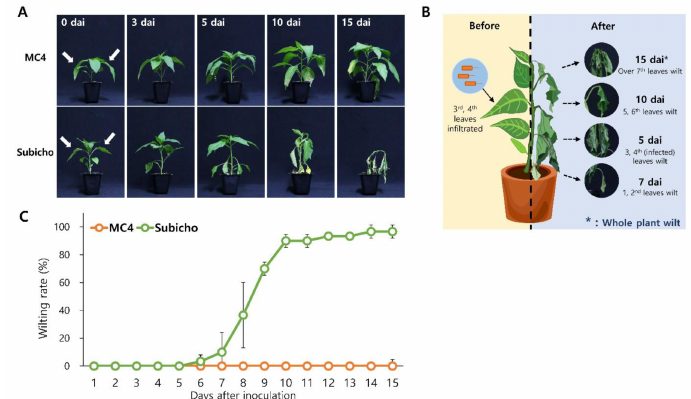
Figure 2. The difference in disease symptoms of leaf to whole plant spread bioassay (LWB) in pepper. Three weeks after transplanting, the eight-leaf stage seedlings were inoculated with R. solanacearum SL1931 by leaf infiltration with bacterial suspensions 1 × 10 6 CFU/mL to give inoculum volume of 0.1 mL/leaf. The plants were incubated in a growth room at 28 ◦ C with 16-h light a day. ( A ) Difference of bacterial wilt (BW) symptom progression in inoculated ‘MC4 (cid:48) and ‘Subicho’. The phenotype of ‘MC4 (cid:48) (R), ‘Subicho’ (S) according to 0, 3, 5, 10, and 15 days after inoculation (dai) is shown. ( B ) Illustration of a procedure in which the whole plant withers after leaf-infiltration. ( C ) Progress degree of wilt disease on ‘MC4 (cid:48) and ‘Subicho’. Disease severity of the plants was investigated every day after leaf inoculation. Green and Orange lines indicate ‘Subicho’ and ‘MC4 (cid:48) . In total, 30 plants were analyzed for each cultivar. The arrows show inoculated leaves. Each data point represents the mean disease index for two independent